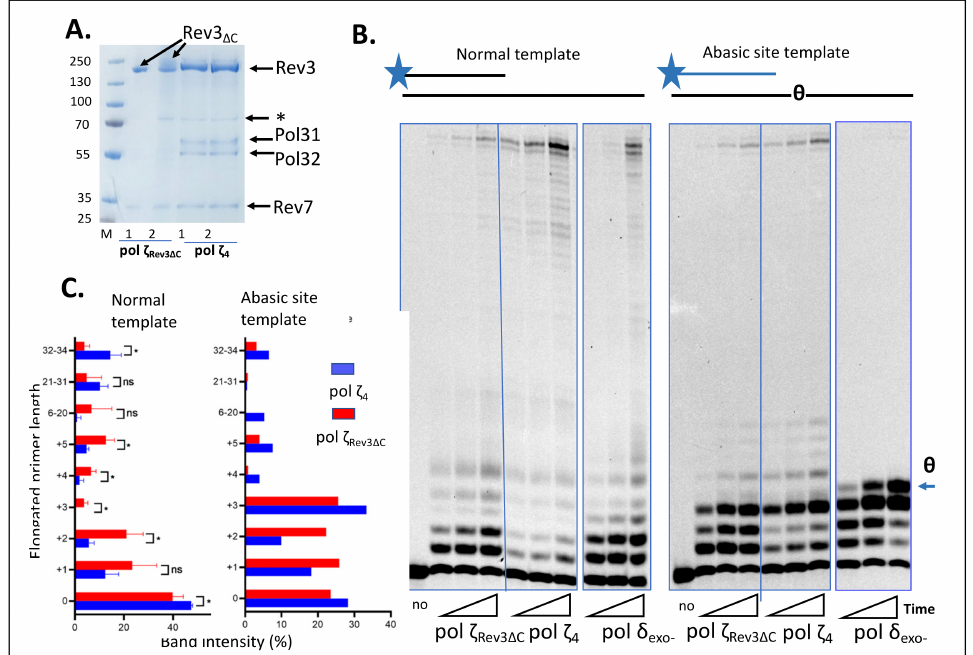
Figure 2. Polymerase ζ lacking C-terminal domain of Rev3 (pol ζ Rev3 ∆ C ) was active and retained the ability to synthesize DNA on damaged templates similar to four-subunit pol ζ . ( A ) The appearance of pol ζ and pol ζ Rev3 ∆ C (two independent preparations on nearby lanes) on Coomassie gel. M-Ruler Plus protein markers, apparent Mr on 4–15% PAAG, are in the left lane. * = chaperone band; “no” = no polymerase added. ( B ) Pol ζ Rev3 ∆ C, like pol ζ 4 , could bypass abasic sites, albeit less efficiently. This activity was distinct from that of pol ∆ , which could not elongate primer termini after the abasic site in the template (marked “ θ ” to the right of the gel). The pol ζ ratio to the substrate was 0.5, that of pol ζ Rev3 ∆ C was 2, and that of pol ∆ was 0.1. Reaction times were 5, 10, 25 min. “no”, no polymerase added to reaction. ( C ) Quantitative comparison of products of synthesis by pol ζ Rev3 ∆ C (red) with pol ζ 4 (blue) on normal template. *, p < 0.05, one-way